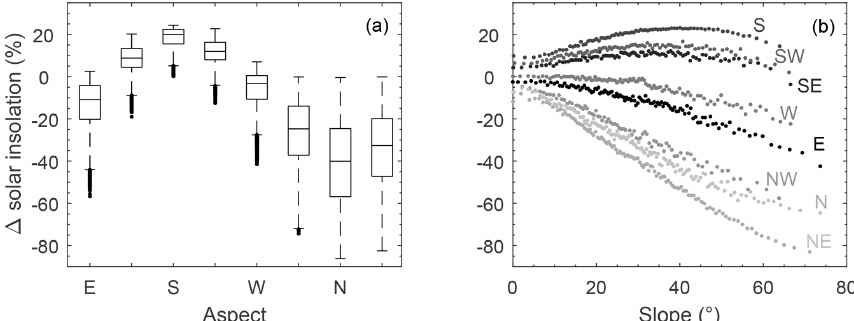
Figure 7. Variation in potential solar insolation relative to a flat surface based on aspect (a) and slope (b) . Box plots show median and interquartile range, with outliers shown as dots. Insolation as a function of slope has been bin averaged per cardinal direction, where each point represents 100 data points. Slope and aspect data are for the Seney WET plot.